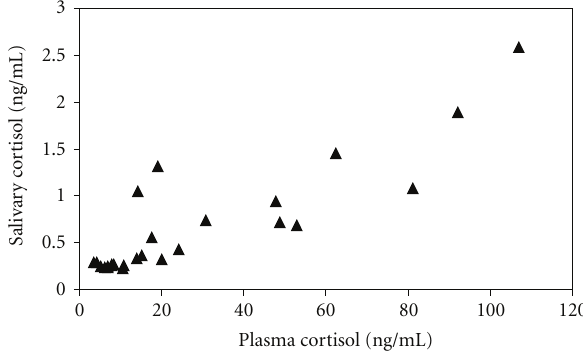
Figure 2: Plasma and Salivary Cortisol. Cortisol values for simul- taneous plasma and salivary samples where the value for salivary cortisol was above the limit of